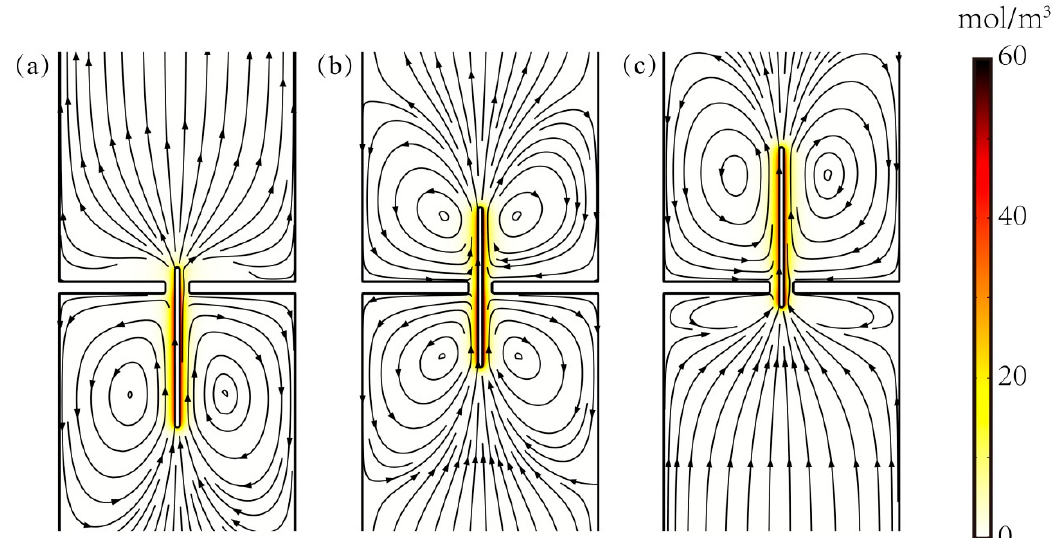
Figure 5. The distribution of the concentration difference c1 − c2 between cation and anion and streamline diagram when the particle length is L p = 200 bp, the particle locates at ( a ) y p = − 75, ( b ) y p = 0, ( c ) y p = 75 bp. The darker colors in the diagram mean the larger value of c1 − c2, and the lines with arrows denote the streamlines of the flow field.